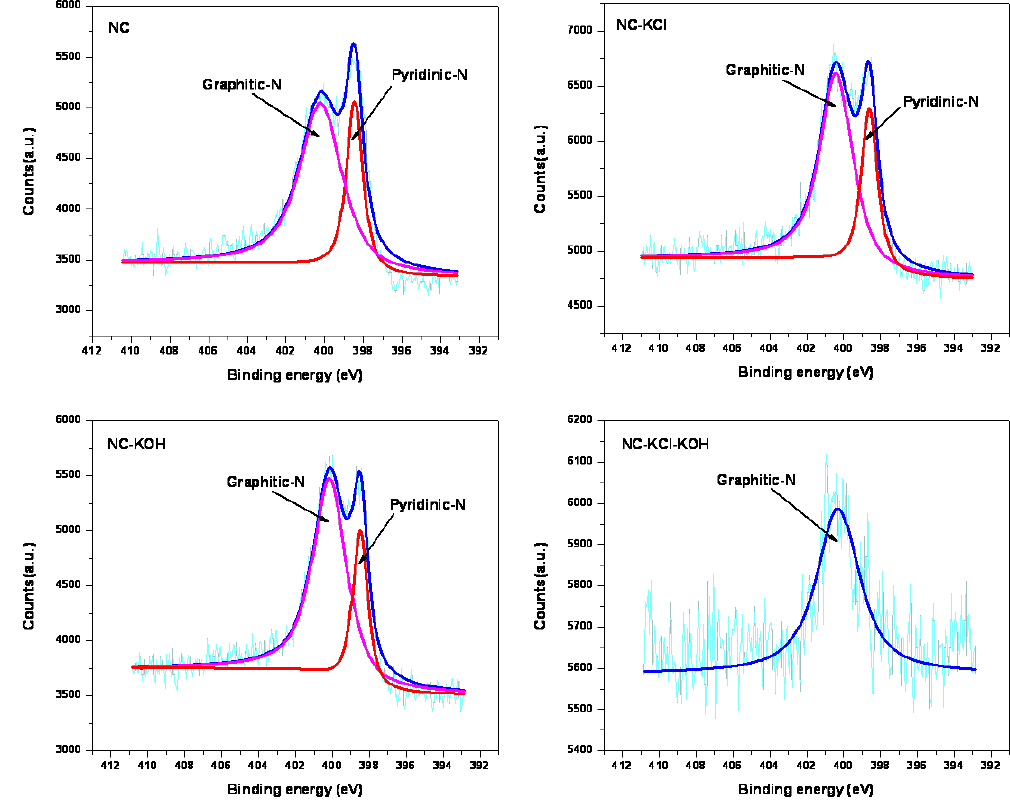
Figure 12. N1s XPS spectra of typical samples.